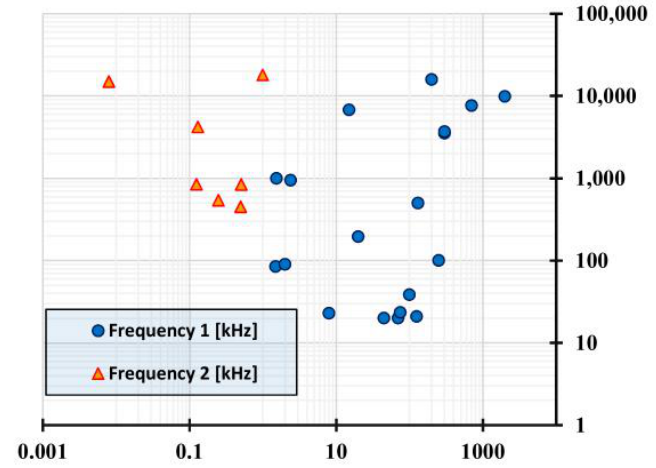
Figure 7. Graph of FREQUENCY vs. GAP DISTANCE